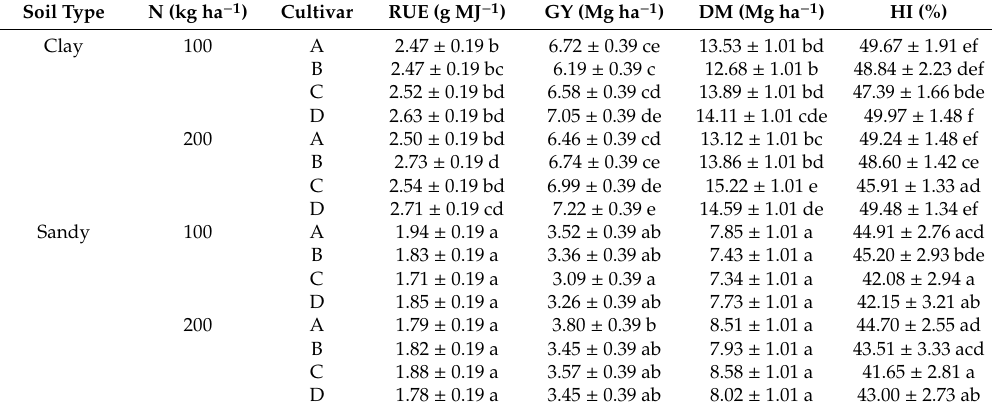
Table 2. Estimated radiation use e ffi ciency (RUE, the slope of linear regression between APAR and DM through origin), grain yield (GY), total aboveground dry matter (DM) and harvest index (HI) of the di ff erent soil types, cultivars and nitrogen-levels across 2013 and 2014. Estimates are presented with standard error of the means. Estimates with the same letters are not significantly di ff erent statistically at p = 0.05 level.